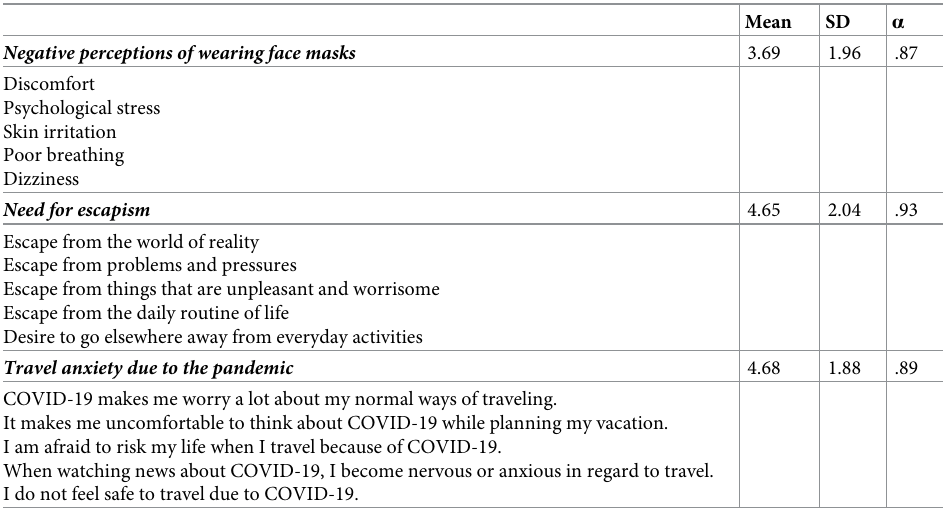
Table 2. Variables and measurement